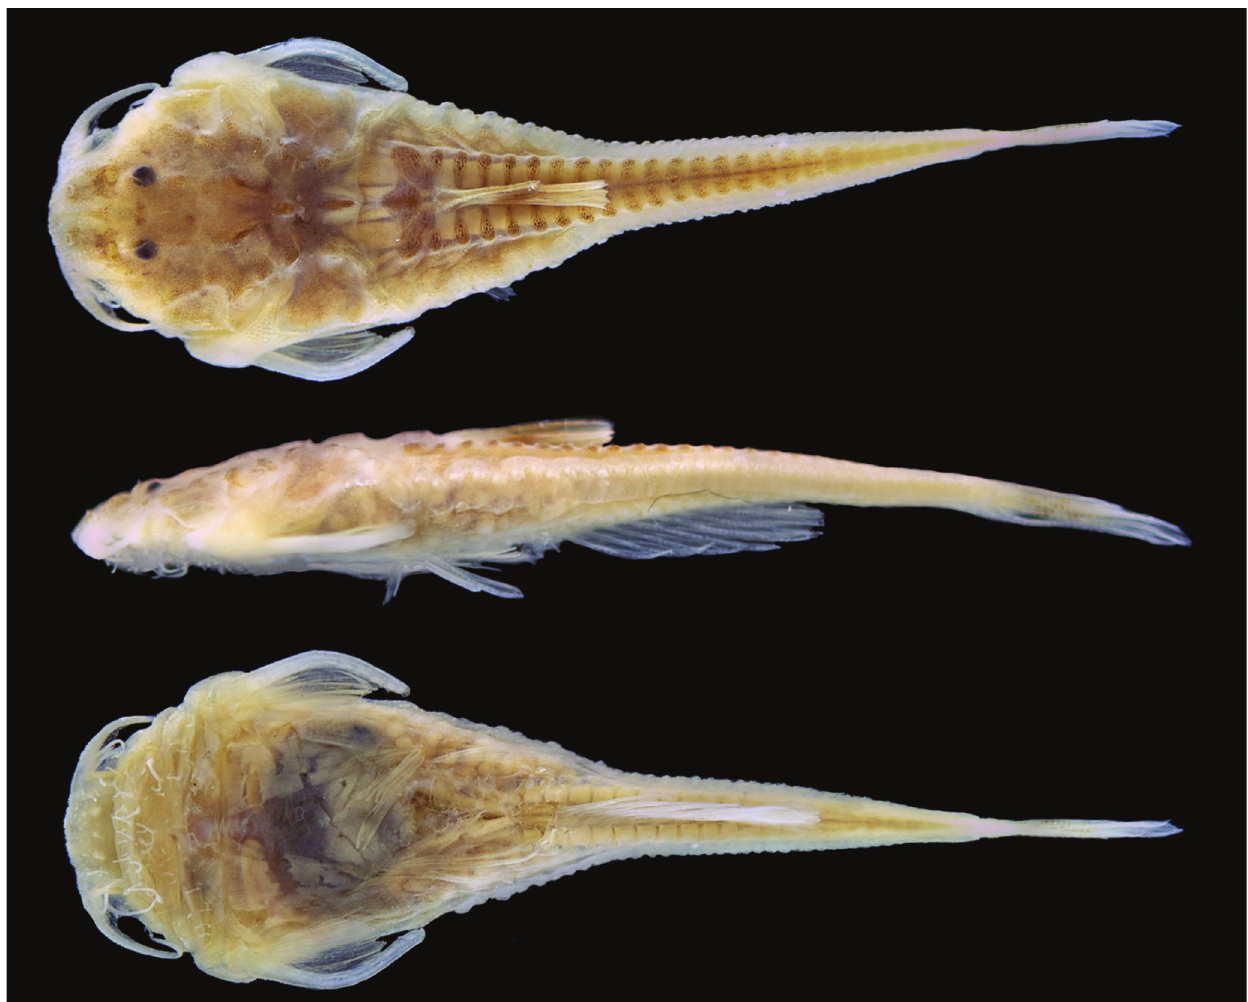
Fig. 1. Hoplomyzon cardosoi , holotype, MCNG 375, 18.5 mm SL, Caño La Raya, Zulia, Venezuela. Dorsal, left side lateral and ventral